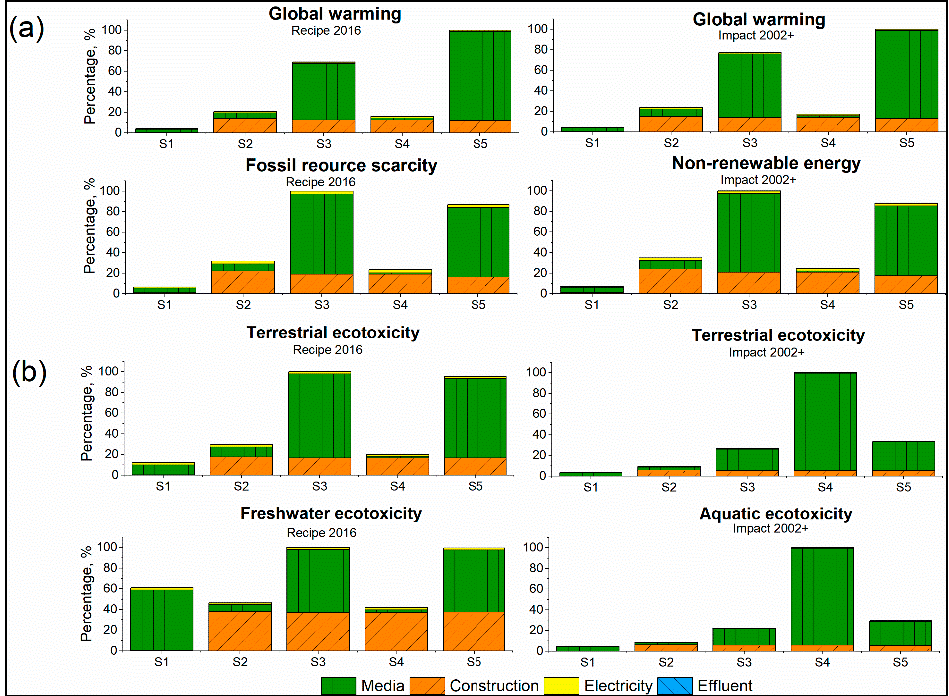
Figure 9. ( a , b ). Comparative scenario of the ReCiPe 2016 and Impact 2002+ methods on ( a ) climate change, energy consumption; and ( b ) terrestrial, freshwater toxicity, related categories.